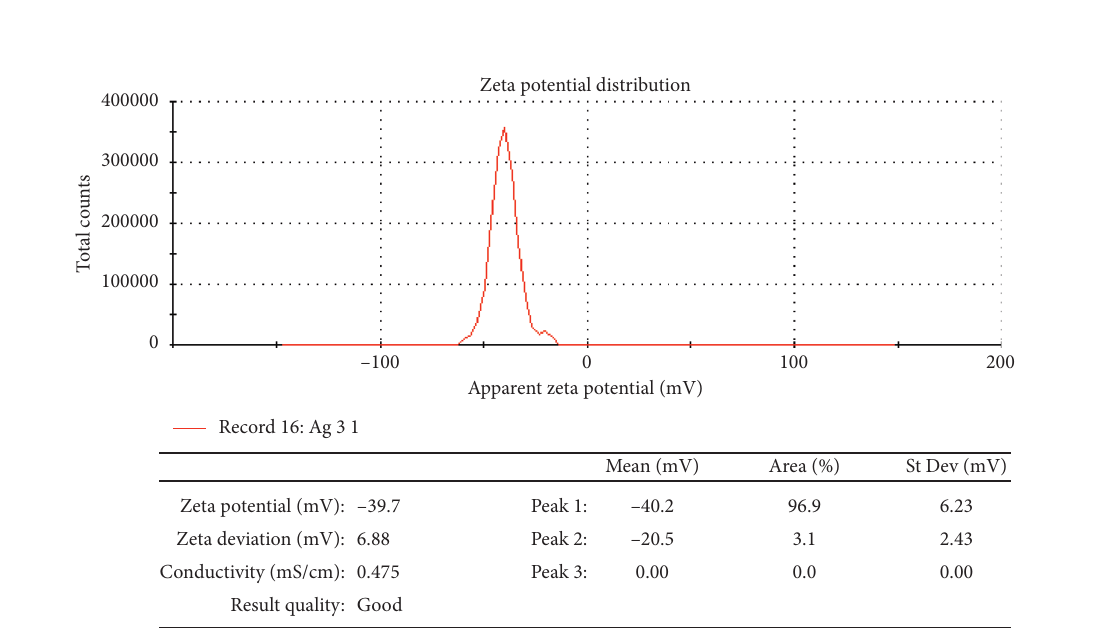
Figure 3: Zeta potential of water colloid silver/PVA (C AgNO